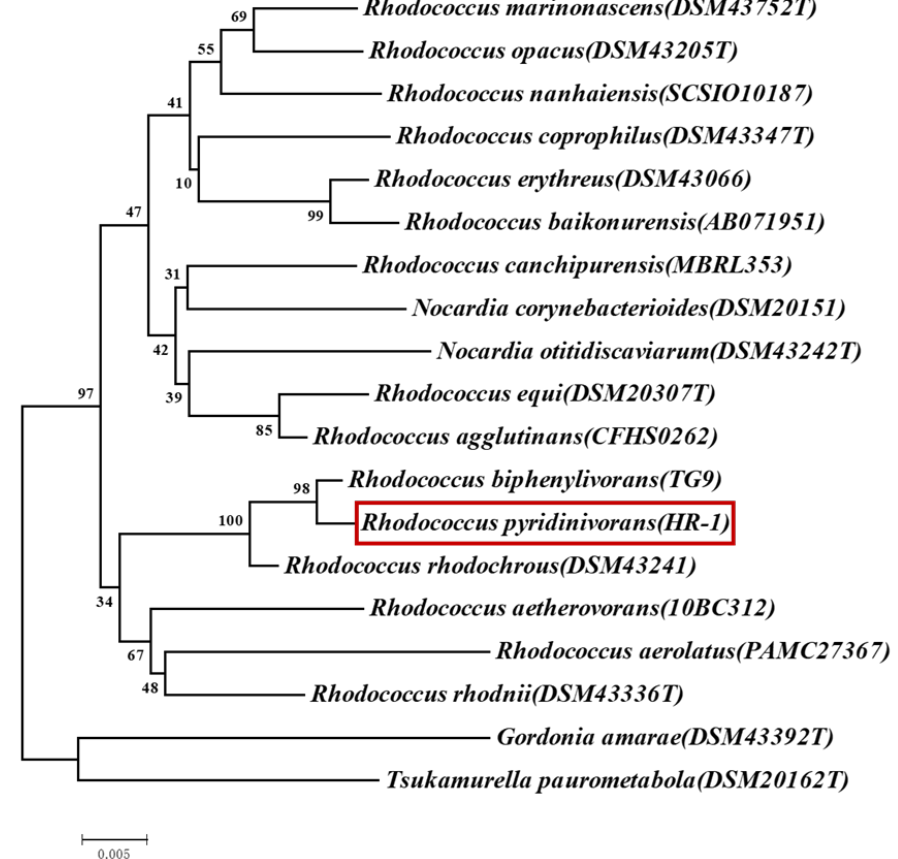
Figure 2. Phylogenetic tree using the 16s rDNA gene sequence to show the links between strain HR-1 and similar species. As an outgroup sequence, the strain Rhodococcus pyridinivorans PDB9 was used. To build the tree, the neighbor-joining technique was used. 1000 replicates were used to obtain the bootstrap values at the nodes (only values greater than 50% are shown).